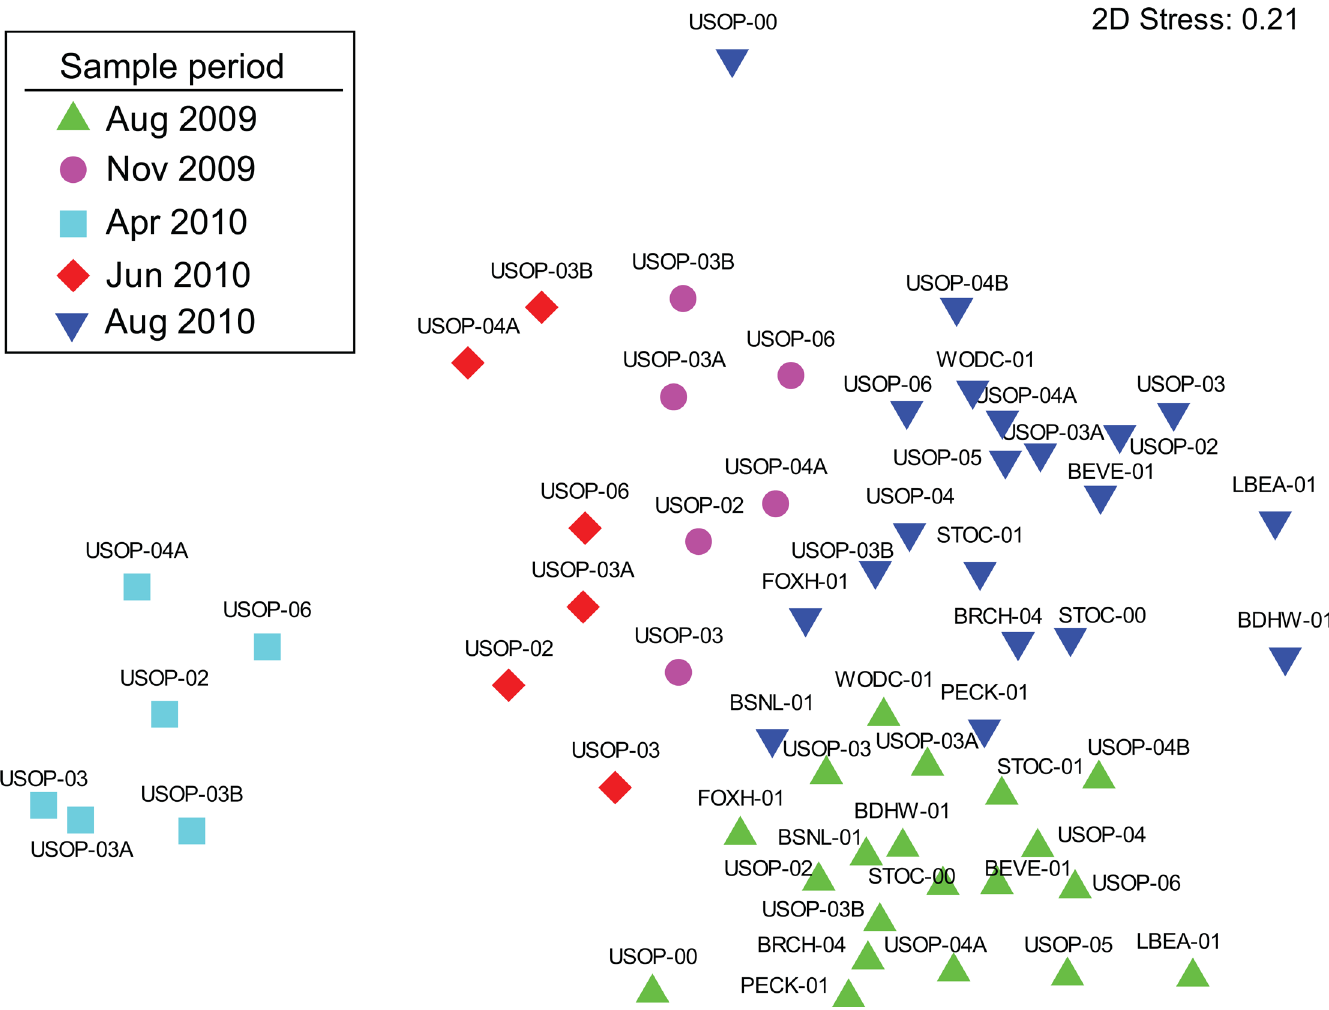
Fig 4. MDS ordination based on fourth-root transformed diatom abundance data for each of the five surveys as indicated by colored symbols.